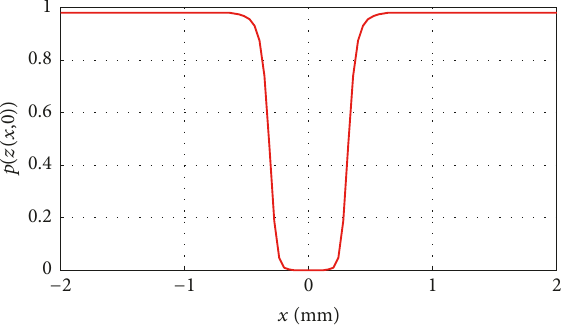
Figure 9: Cross-section of the function 𝑝(𝑧(𝑥,𝑦)) when 𝑦 = 0 mm.